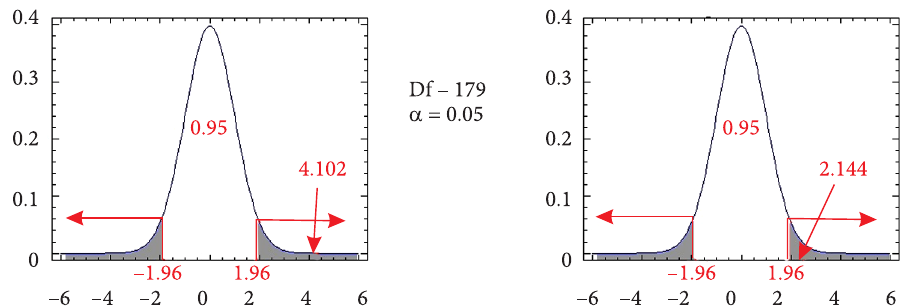
Figure 1. Verification of the model variables (ICT trends – left; Finance – right) (source: own processing)